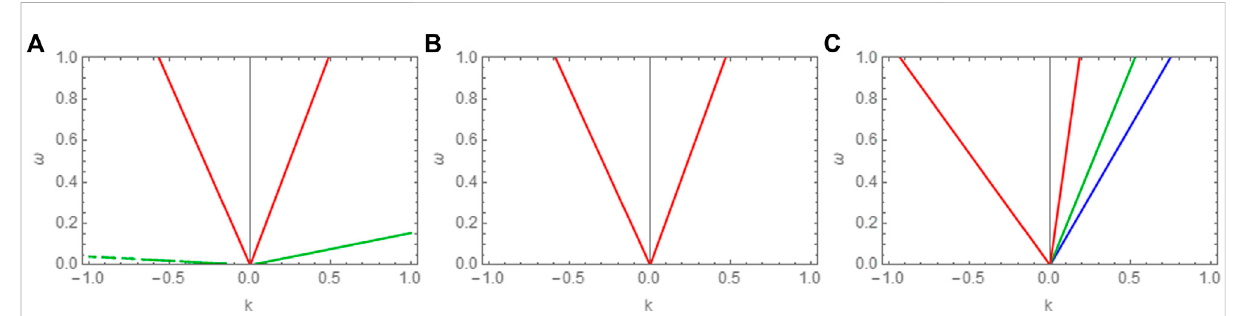
Variation of roots of phase velocity λ (= ω / k ) for different values of v b 0 . (A) ; v b 0 = 0.2 (B) ; v b 0 = 0.3 (C) ; v b 0 = 3.8. Remaining fi xed parameters are q = 2.5, r = 0.8, σ c = 0.001, σ b = 0.01, n c